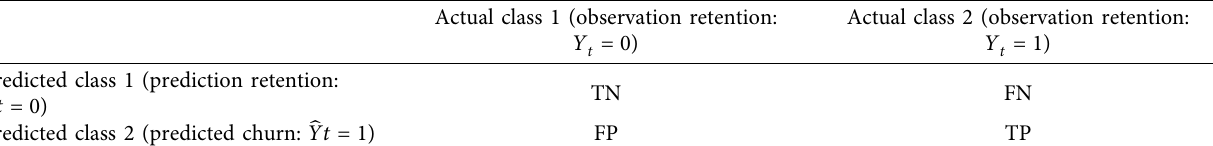
Table 3: Confusion matrix for the evaluation of binary classification.